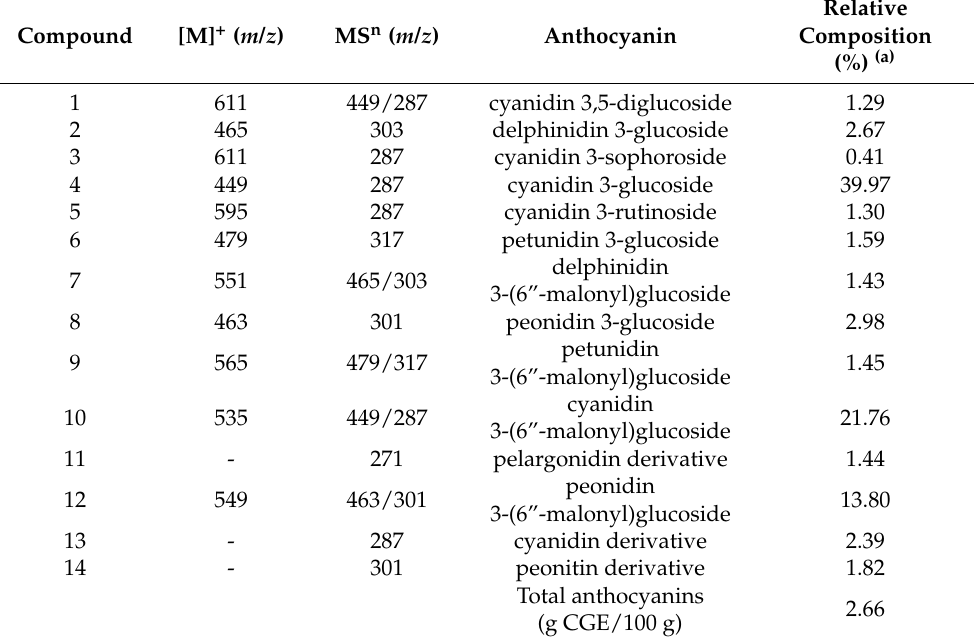
Table 1. Anthocyanin profile of red orange and lemon extract